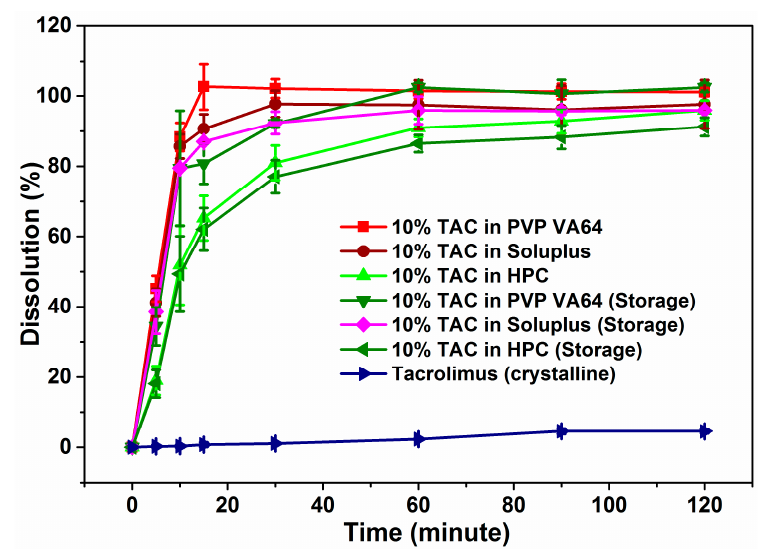
Figure 7. Dissolution profiles of solid dispersions of TAC before and after storage.